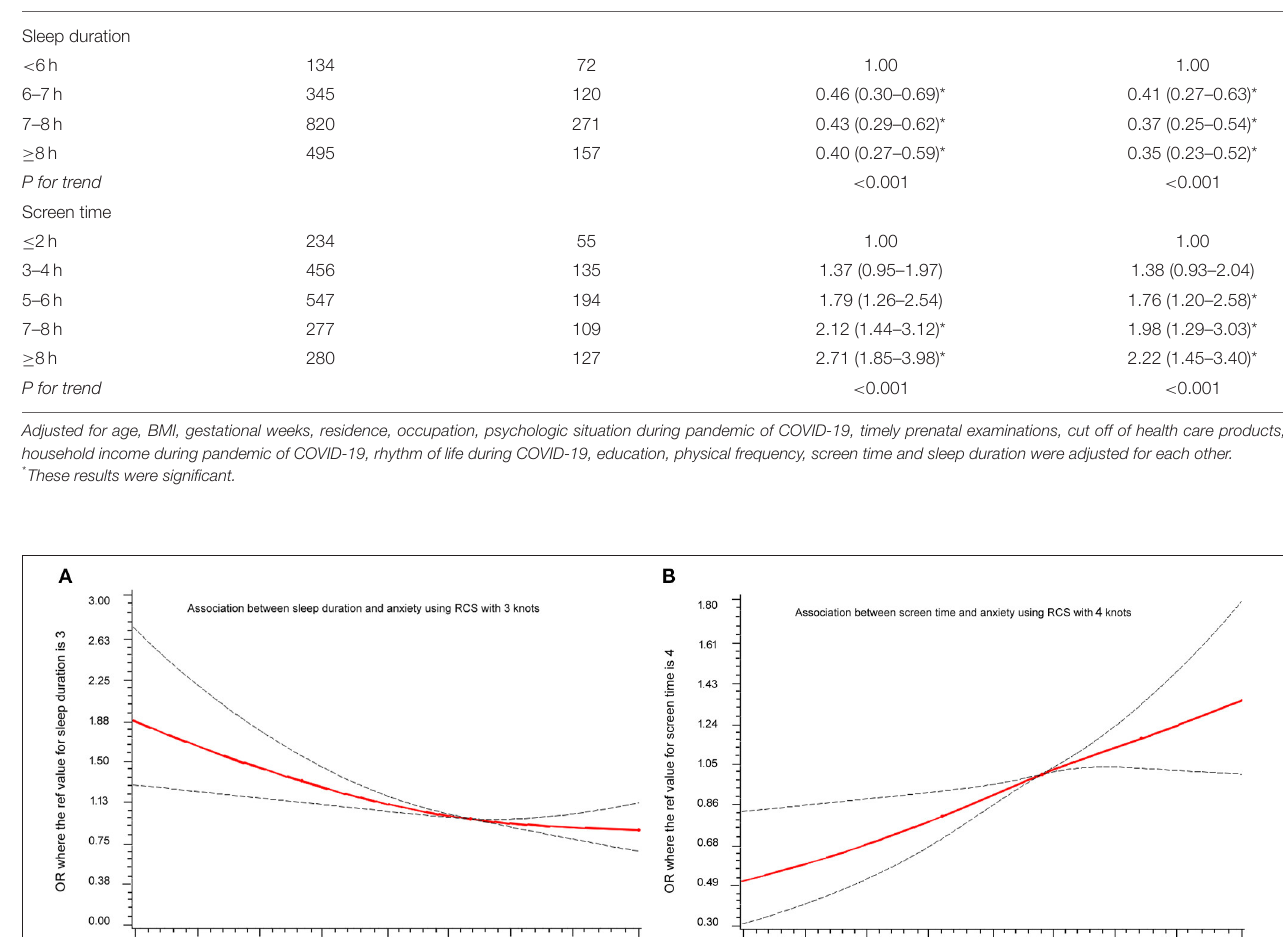
the linear regression analysis also presented similar results ( Supplementary Table 2